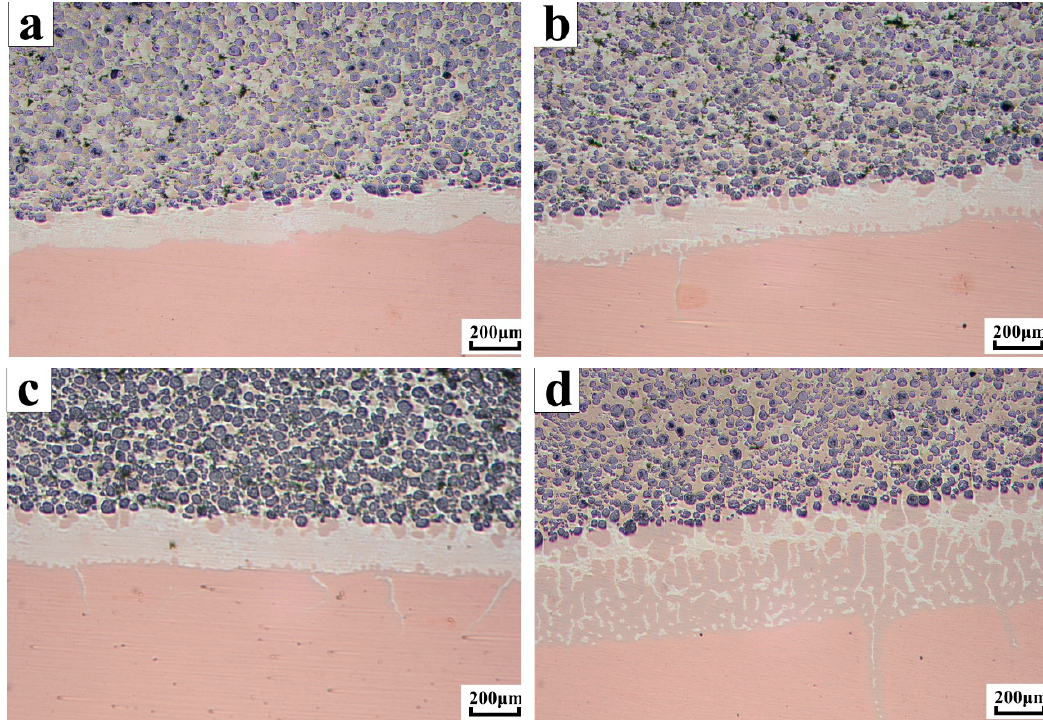
Figure 4. Microscopic morphology of composite coatings at different temperatures ( a ) Micro-morphology of composite coating at a brazing temperature of 830 ◦ C; ( b ) Micro-morphology of composite coating at a brazing temperature of 860 ◦ C; ( c ) Micro-morphology of composite coating at a brazing temperature of 890 ◦ C; ( d ) Micro-morphology of composite coating at a brazing temperature of 920 ◦ C.